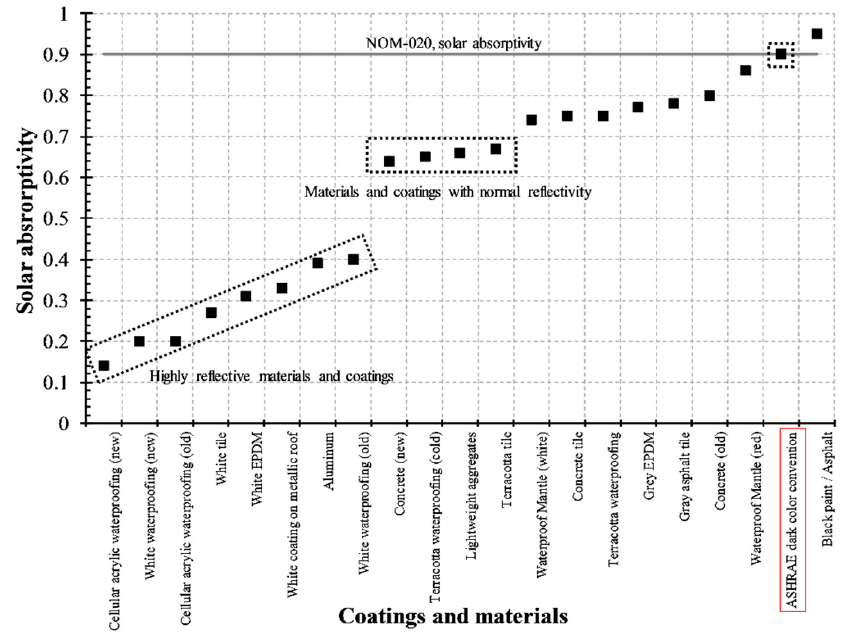
Figure 5. Solar absorptivity of commercial materials and coatings. EPDM: Ethylene Propyelene Diene Methylene.